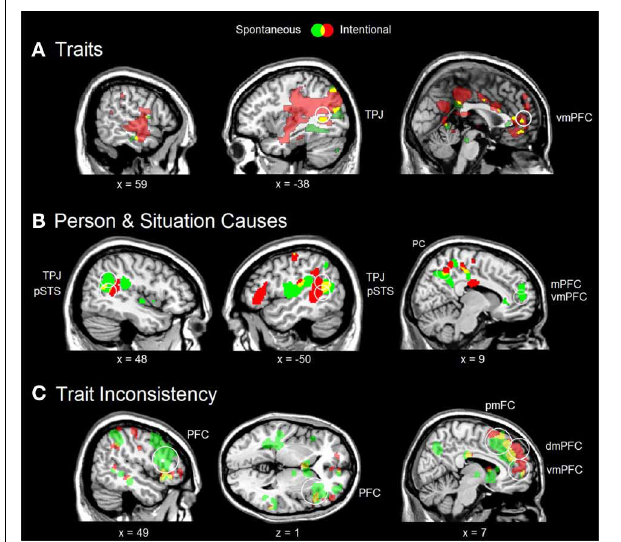
FIGURE 2 | Various social inferences under spontaneous (green) and intentional (red) instructions, and their overlap (yellow). (A) Consistent trait > irrelevant trait contrast from Ma et al. (2011) with significant conjunction in the left TPJ (MNI coordinates − 58 − 58 32). (B) Person Cause > Baseline and Situation Cause > Baseline conjunction from Kestemont et al. (2013) with significant conjunction in the bilateral TPJ and pSTS (respective MNI coordinates 46 − 56 20; − 50 − 54 18; 52 − 56 14; − 50 − 56 16). (C) Inconsistent trait > Consistent trait contrast from Ma et al. (2012a) with significant conjunction in the mPFC (MNI coordinates 4 42 32). In all analyses, whole-brain activation was thresholded at p < 0 . 005 (uncorrected) with at least 10 voxels. Circles indicate regions of interest with significant activation after FDR correction at p < 0 . 10. vmPFC, ventral part of the mPFC; dmPFC, dorsal part of the mPFC; pmFC, posterior frontal cortex; PFC, lateral prefrontal